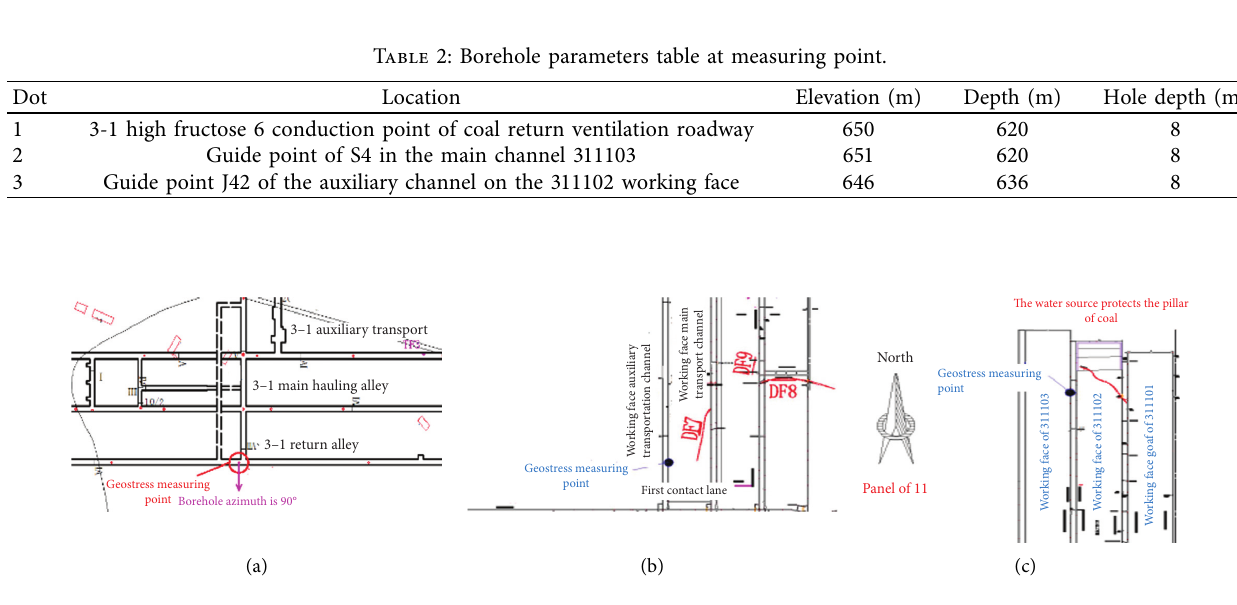
Figure 3: Schematic diagram of ground stress measuring point layout. (a) Point 1. (b) Point 2. (c) Point 3.